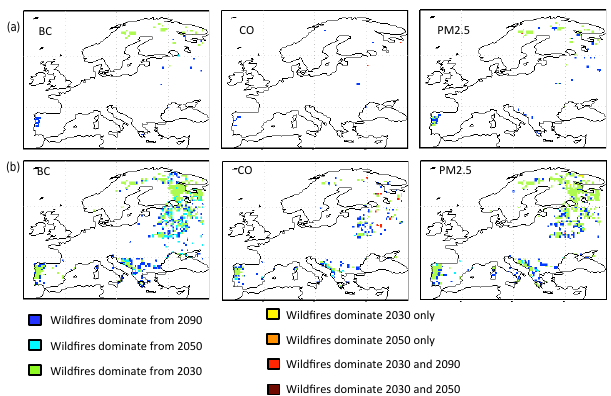
Figure 5. Areas where wildfire emissions exceed anthropogenic emissions in 2030, 2050 or 2090 on annual basis (a) or during peak fire season (b) (month of maximum wildfire emissions varying by grid cell), assuming RCP8.5 climate, SSP5 population and maxi- mum feasible reduction anthropogenic